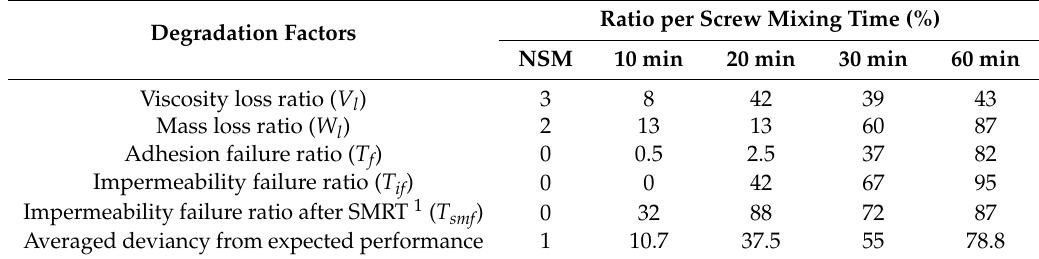
Table 8. Estimation of the deviancy from the expected performance of SPRG (1 day